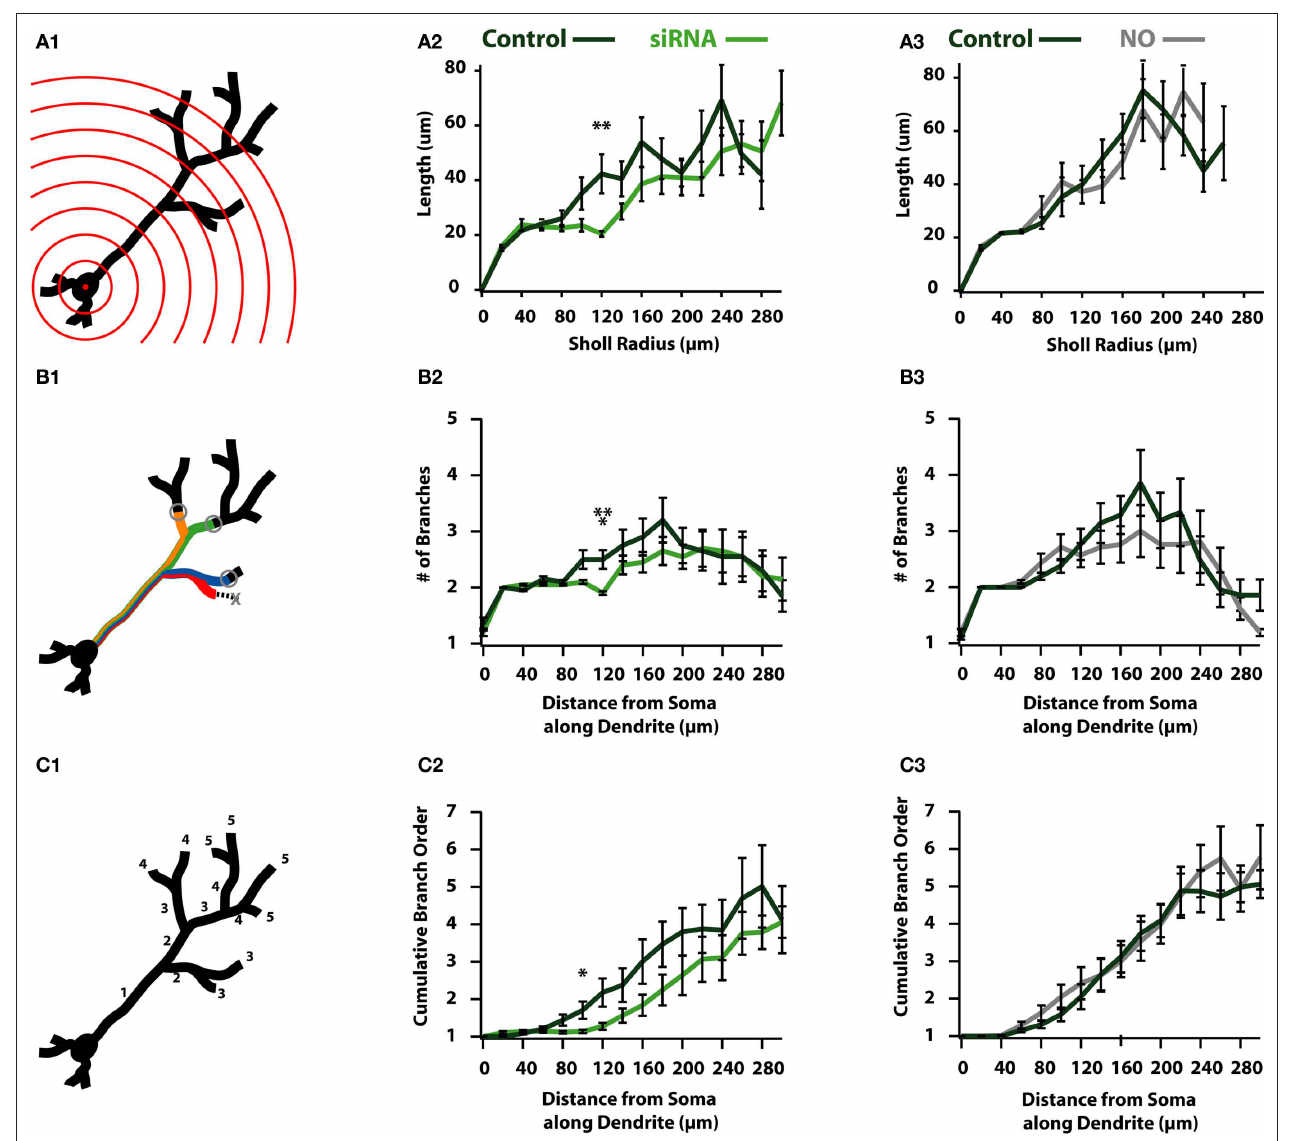
significant reduction in the number of branches at proximal-intermediate distances from soma (at 120 μm: p < 0.001, n = 20). (B3) NO cells show no significant differences in modified Sholl analysis. (C1) Cumulative branch order along length of apical dendrite. Plotted as the cumulative branch order (where branch order increments by one following bifurcation) vs. distance from soma along apical dendrite length. (C2) siRNA knock-down cells show a significant reduction in cumulative branch order at proximal-intermediate distance from soma (at 100 μm: p < 0.05, n = 20). (C3) NO cells show no differences in cumulative branch order.